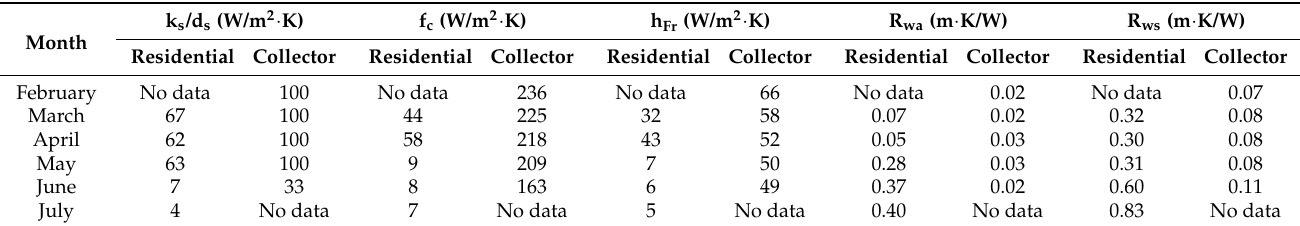
Table 2. Values of the calibrated ratio of soil penetration depth to soil thermal conductivity (d s /k s ), calibrated heat transfer coefficient factor ( f c ) for heat transfer between wastewater and in-sewer air, the heat transfer coefficient ( h Fr ) and the thermal resistivity values between wastewater and in-sewer (R wa ) and soil (R ws ) for the 2020 model. k s /d s (W/m 2 · K) f c (W/m 2 · Month